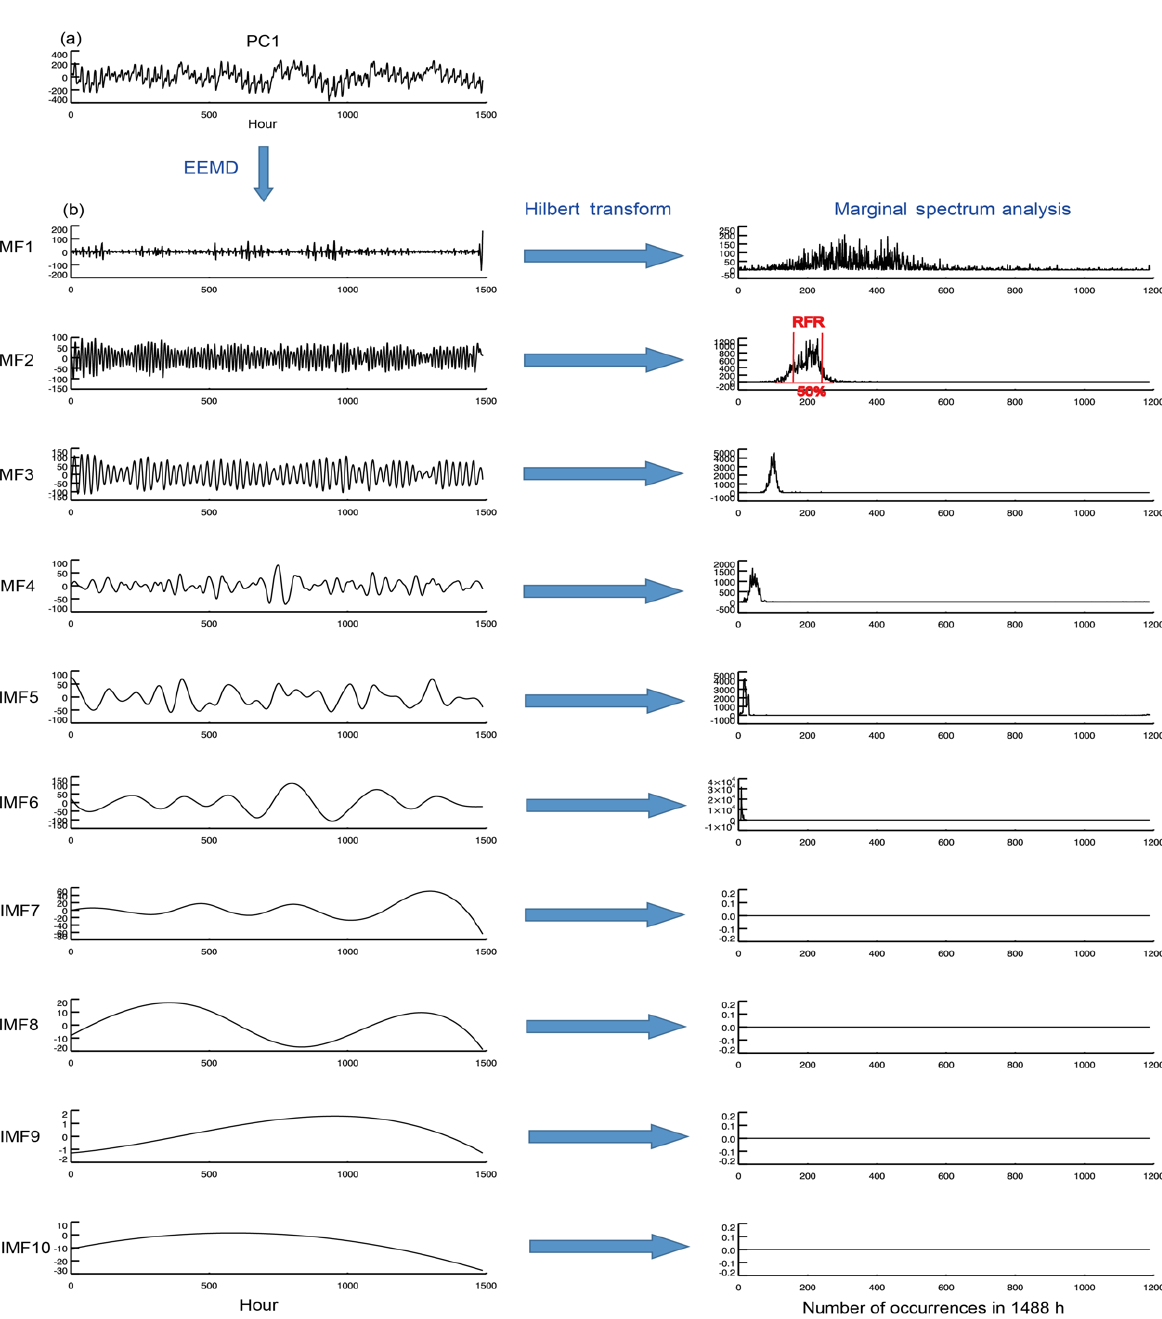
Figure 4. EEMD–HT–MSA result for PC1 of observed NO 2